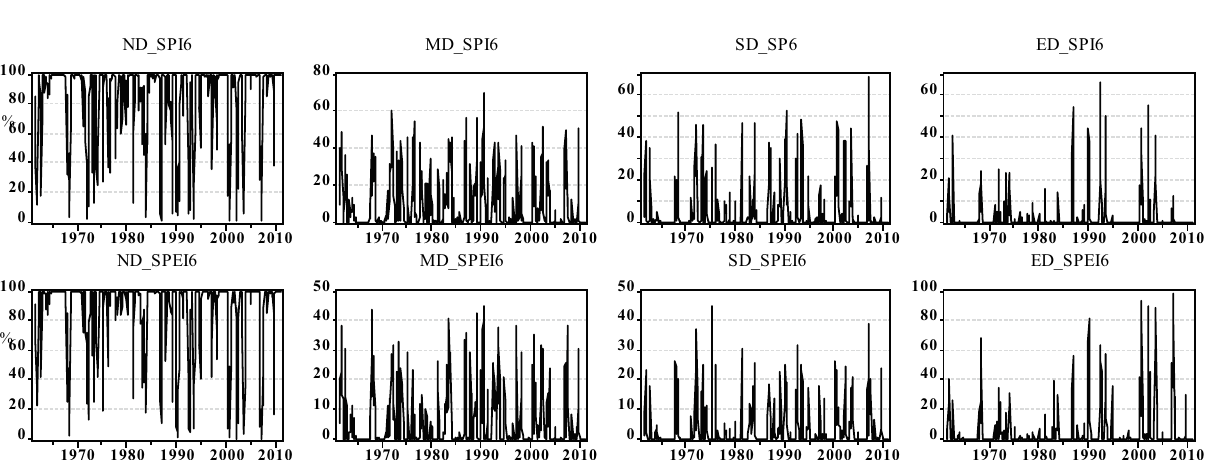
Figure 7. Ω(%) of different agricultural drought (SPI-6 and SPEI-6) categories between 1961 and 2010 across Hungary (figure was generated using EViews (https:// www. eviews. com/ home. html)).